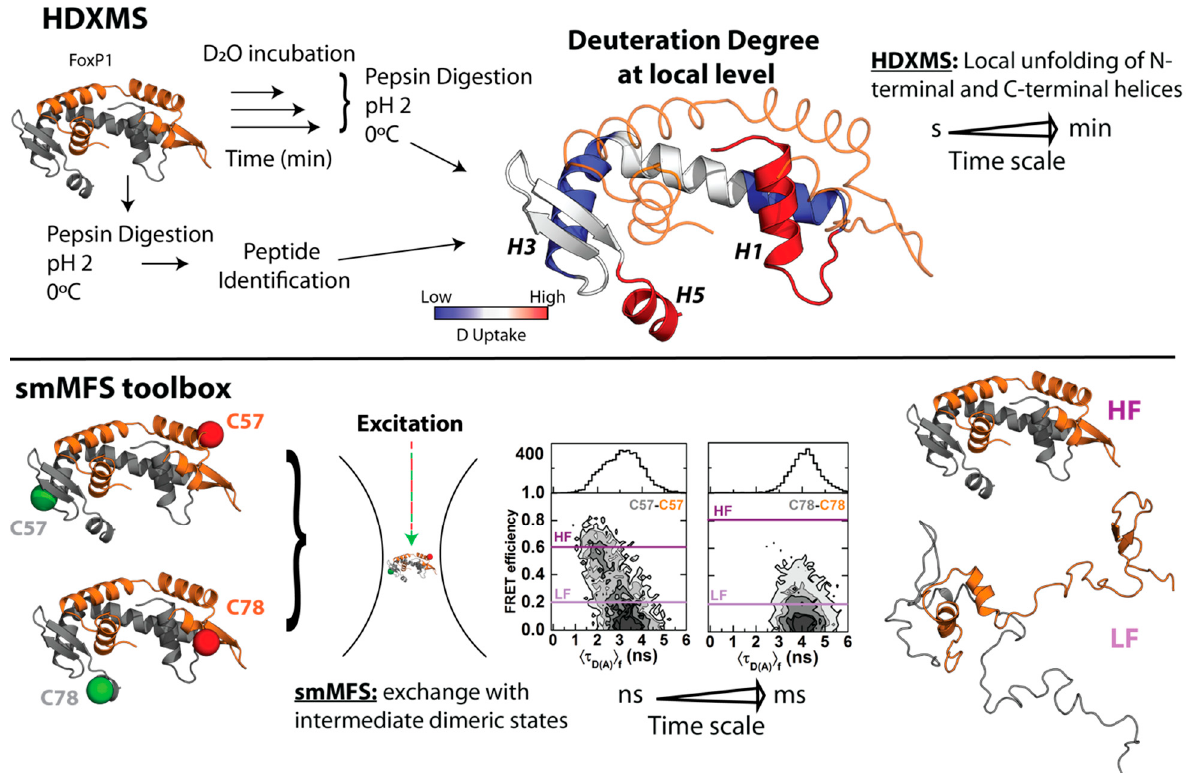
Figure 2. Insights into the 3D-DS pathway in FoxP1. Using high-resolution experimental and computational approaches, the mechanism by which FoxP1 dimerizes via 3D-DS was proposed. By using HDXMS, differences in flexibility between secondary structure elements of the protein suggested that helices H 1 and H 5 and strand S 1 are prone to unfold in the monomer (in red), facilitating the accumulation of the monomeric intermediate described in equilibrium unfolding experiments. To detect these differences, the protein is first incubated in deuterated buffer (D 2 O) at different times (from seconds to few minutes); then, the reactions are quenched, and lastly, the sample is pepsin-digested, and all identified peptides are analyzed by mass spectrometry. In addition, a smMFS toolbox was used to describe the local dynamics of the double-labeled 3D-DS dimer at the single-molecule level under pulsed interleaved excitation (PIE) in a confocal volume, finding the presence of the predicted folded dimer (High-FRET state, HF) and the accumulation of a dimeric intermediate ensemble that is locally unfolded (Low FRET, LF). As an example, we show the results from two different FRET pairs (C57–C57 and C78–C78), which monitor the dynamics between helices H 3 of the dimer, or between helices H 3 and H 5. The differences between FRET populations in both sets of FRET pairs indicates the differences in structural behavior of different regions of the same protein. By comparing the measured FRET distances with those intermediate structures observed in folding molecular dynamics simulations, a structural view of the mechanism of 3D-DS in FoxP can be inferred. The time scales for HDXMS and smMFS are shown to describe their temporal resolution.